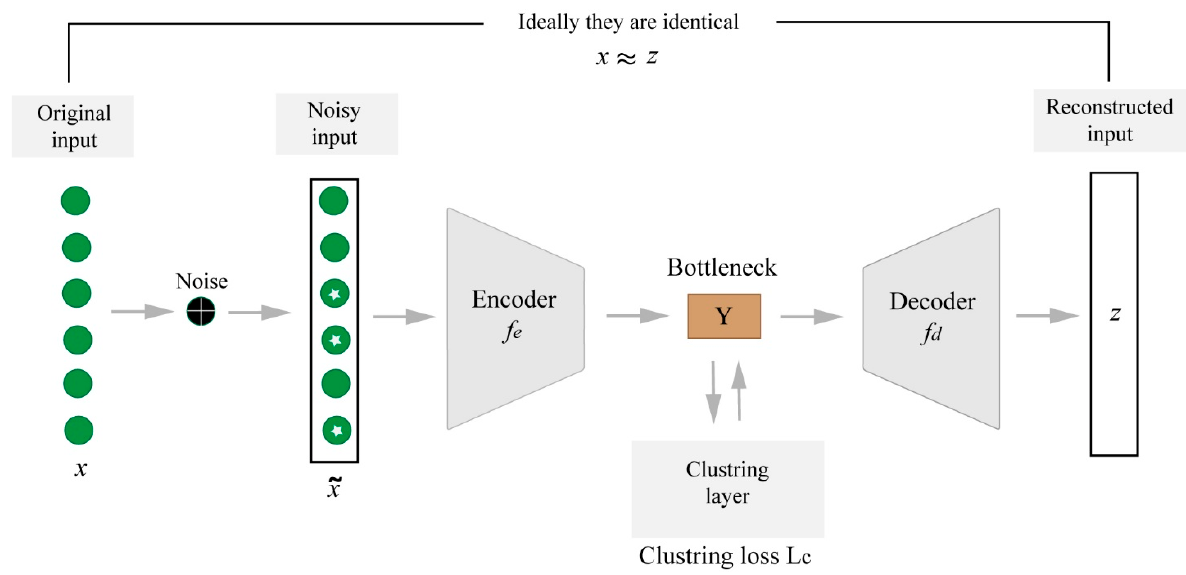
Figure 2. The illustration of the FIDC method. It is made up of four parts: input, encoder part, clustering, and Decoder part. The original input x is related to a fashion image, the CNN feature. Parameter (cid:101) x is obtained by adding noise to the original input. According to the encoder function, a latent representation Y is calculated. The clustering task is executed based on Y